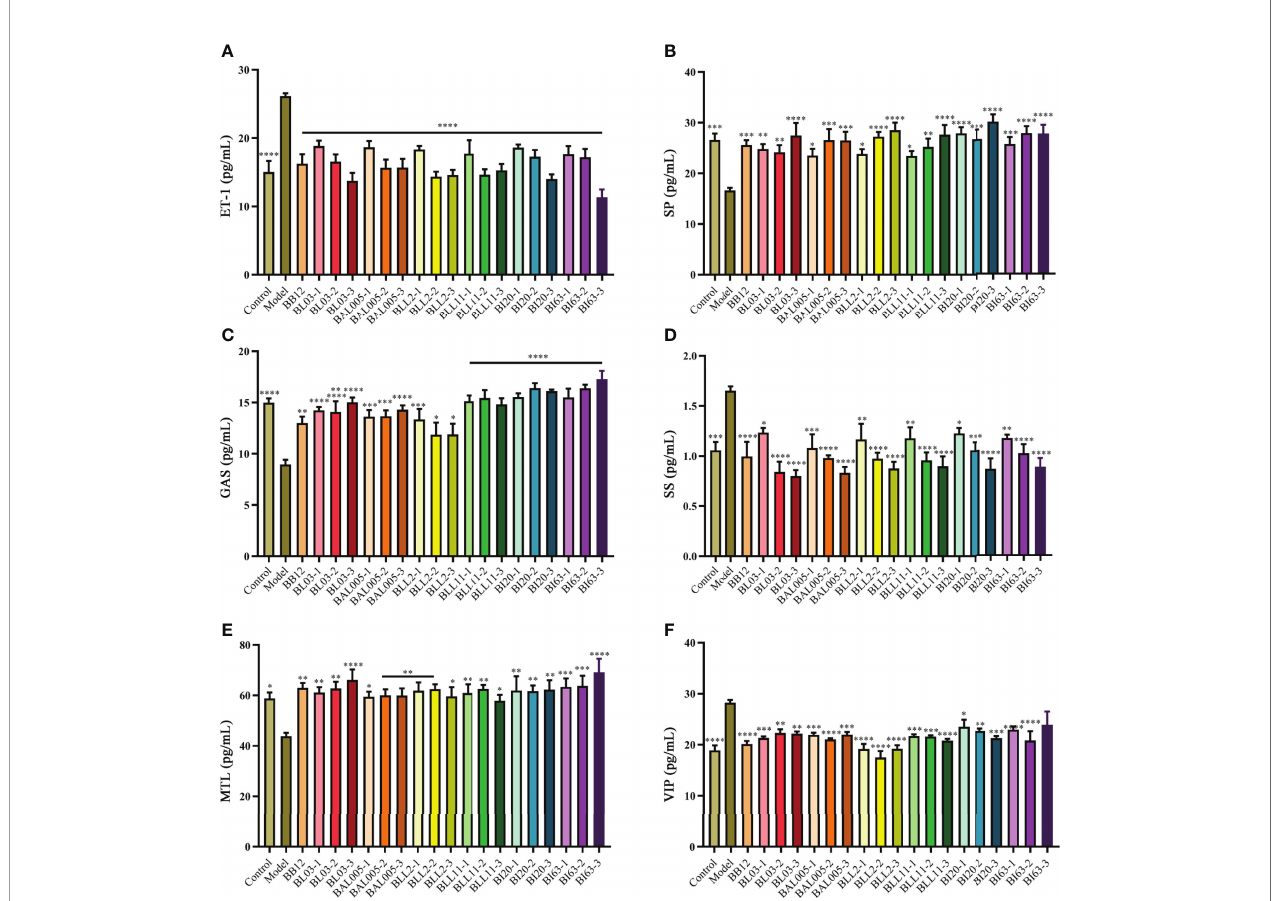
FIGURE 3 | The levels of gastrointestinal regulatory peptides in serum of mice. ET-1 (A) . SP (B) . GAS (C) . SS (D) . MTL (E) . VIP (F) . There is a signi fi cant difference between the bacterial intervention group and the model group, where * means P < 0.05, **P < 0.01, ***P < 0.005, ****P <